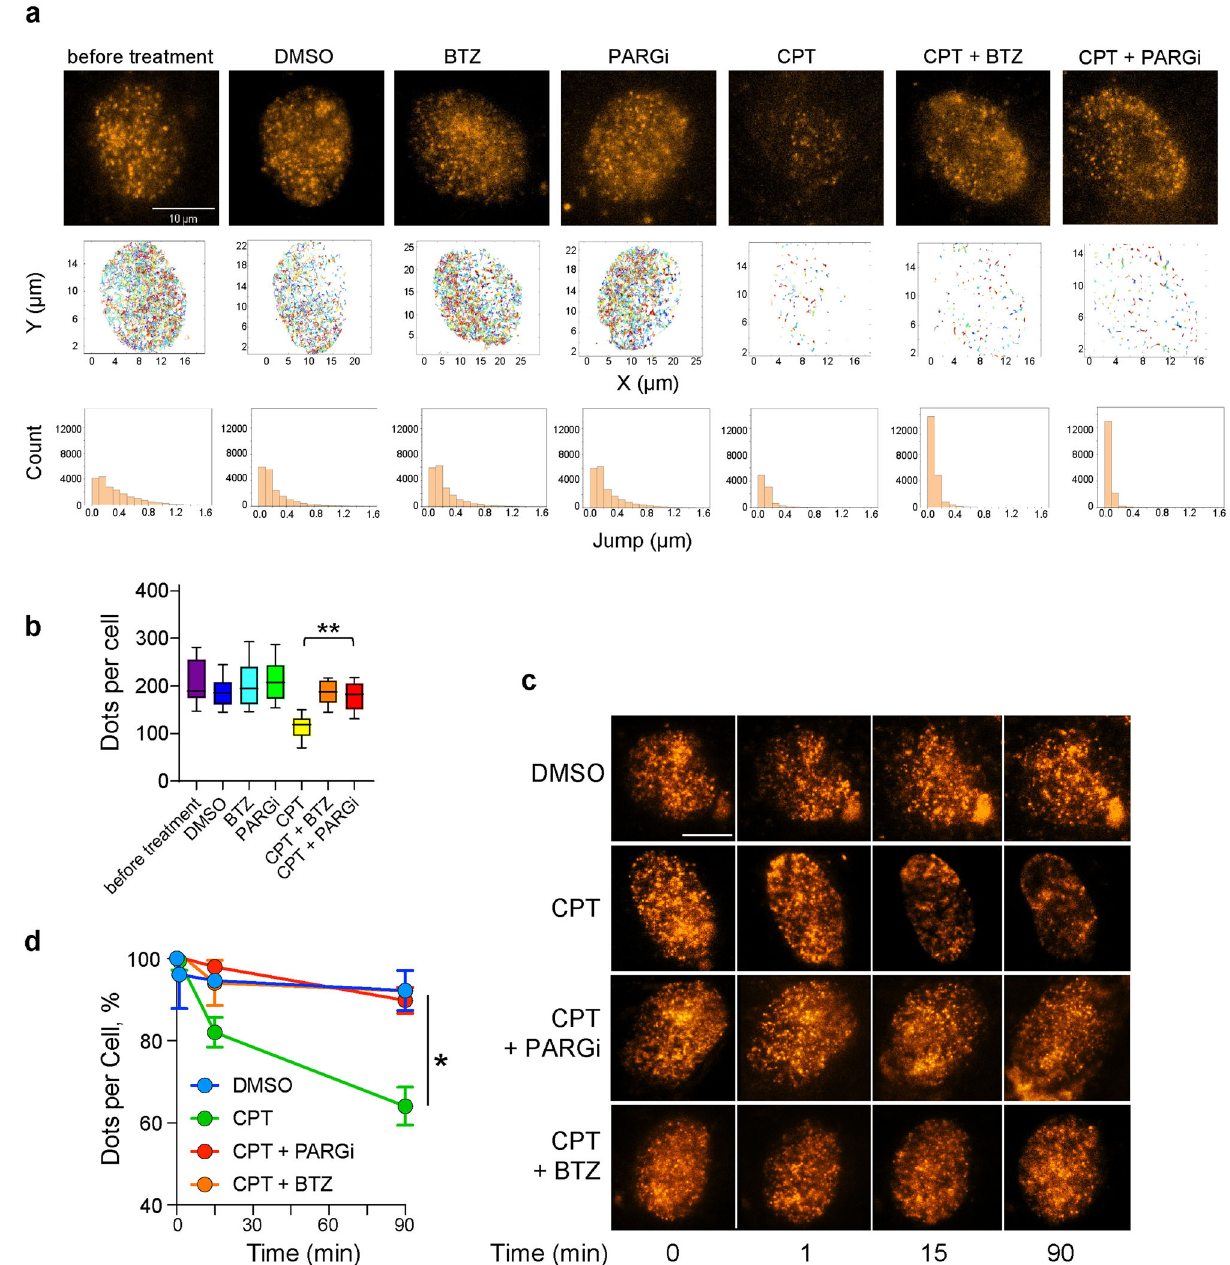
Fig. 1 Identi fi cation of PARG as repair factor for TOP1-DPC by single-molecule tracking. a Top panels: fi lming of TOP1-HaloTag single molecules in U2OS cells transfected with TOP1-HaloTag expression plasmid. The cells were divided into seven groups: no treatment, DMSO (2h), BTZ (10 μ M, 2h), PARGi (10 μ M, 2h), CPT (100 μ M, 2h), CPT + BTZ and CPT + PARGi. Middle panels: plots of tracks of TOP1-HaloTag single molecules in the top-panel fi lms. The tracks were reconstructed in two dimensions by MATLAB analysis pipeline. The neighboring tracks are of different colors to distinguish one from the others. Bottom panels: count of jumps of TOP1-HaloTag single molecules derived from the top-panel fi lms. The X -axis of the histogram is the jump distance of TOP1 single molecules in the top-panel fi lms and the Y -axis is the count of the jumps. The bin size is 0.1 μ m. For example, the “ before treatment ” sample has 4120 jumps whose distances are between 0 and 0.1 μ m and 86 jumps whose distances are between 1 and 1.2 μ m. The sample has a total of 19120 jumps that are the sum of the count of each bin. b Quantitation of TOP1-HaloTag single molecules shown in panel ( a ) using ThunderSTORM, an ImageJ plug-in. Top lines are maximum values, bottom lines are minimum values and middle lines are medians. Box limits indicate the range of the central 50%. Whiskers are upper and lower quartiles. n = 10 biologically independent samples. P value was calculated by paired Student ’ s t-test (two-tailed distribution). **: p = 0.0017. c Time-course of TOP1-HaloTag single molecules in U2OS cells treated with DMSO, CPT (100 μ M), CPT (100 μ M) + PARGi (10 μ M) and CPT (100 μ M) + BTZ (10 μ M). Images were taken at the indicated time points. The scale bar represents 10 μ m. d Quantitation of TOP1- HaloTag single molecules shown in panel ( c ). n = 2 independent experiments. Data are presented as mean values + / − standard deviation (SD). P value comparing TOP1 single molecules of CPT and CPT + PARGi was calculated by paired Student ’ s t-test (two-tailed distribution). *: p = 0.038.